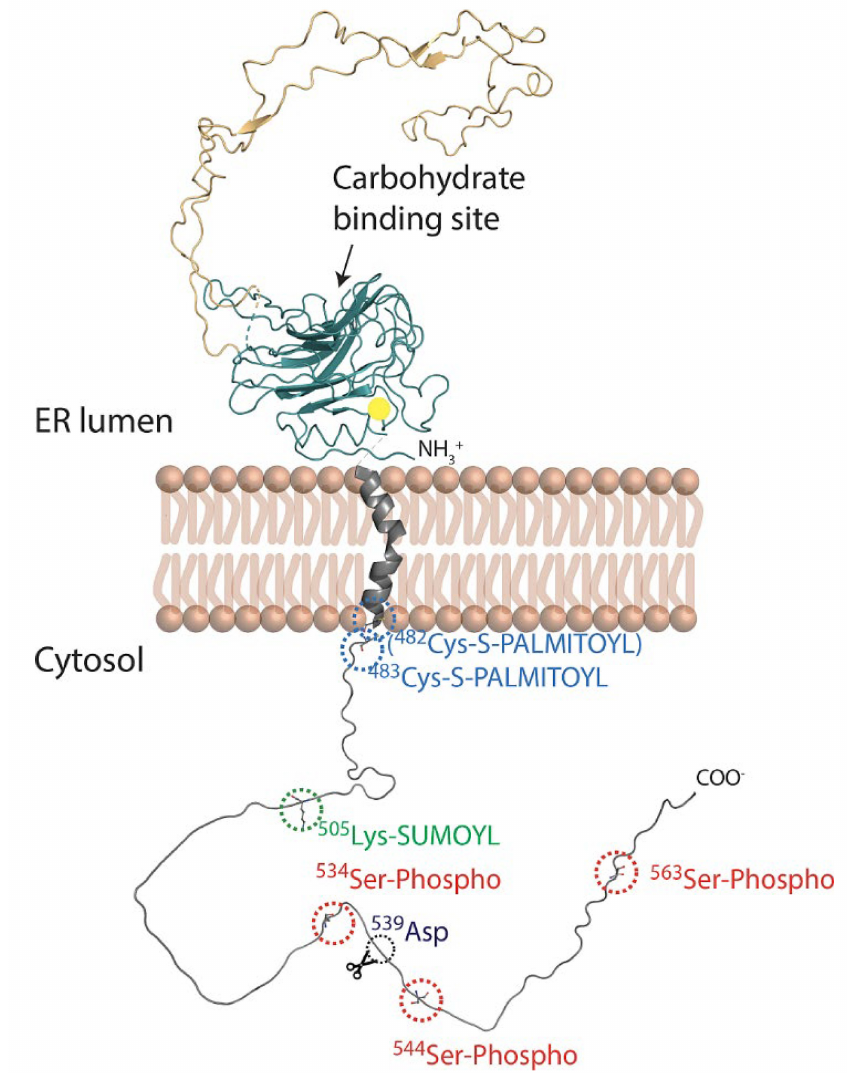
Figure 3. Schematic representation of full-length membrane-embedded calnexin. Calnexin (Protein Data Bank DOI: 10.2210/pdb1JHN/pdb) has three domains: luminal domain (comprised of